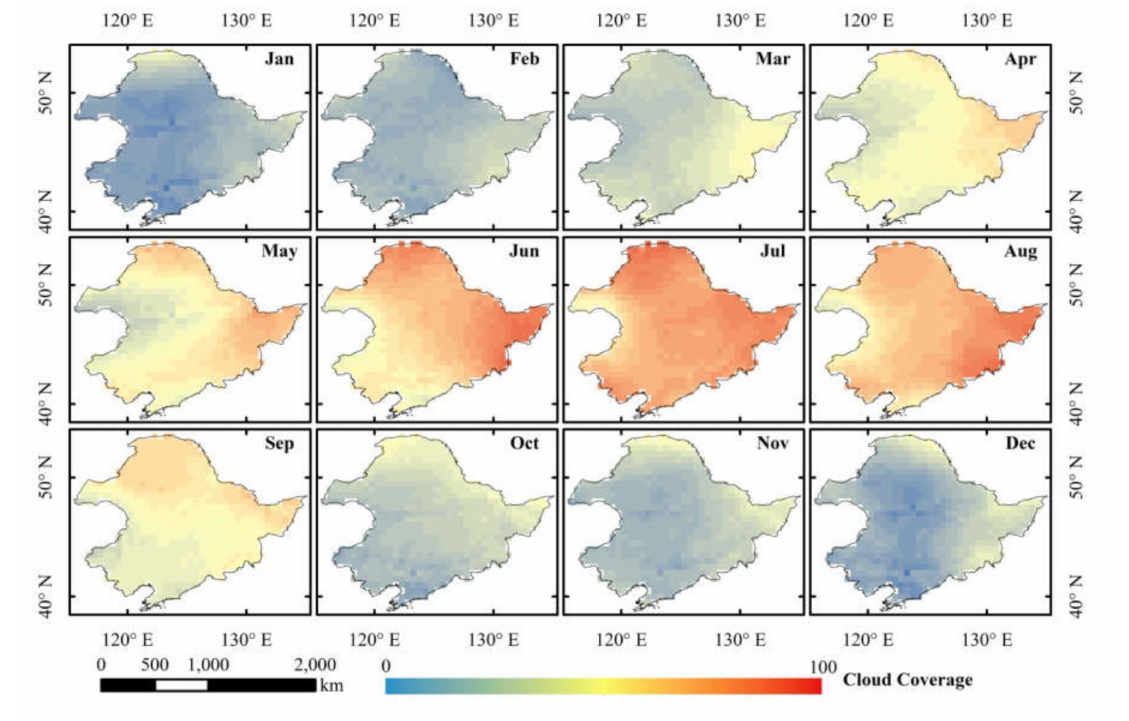
Figure 4. Average cloud coverage every month in Northeast China from 2014 to 2018, determined based on CRU